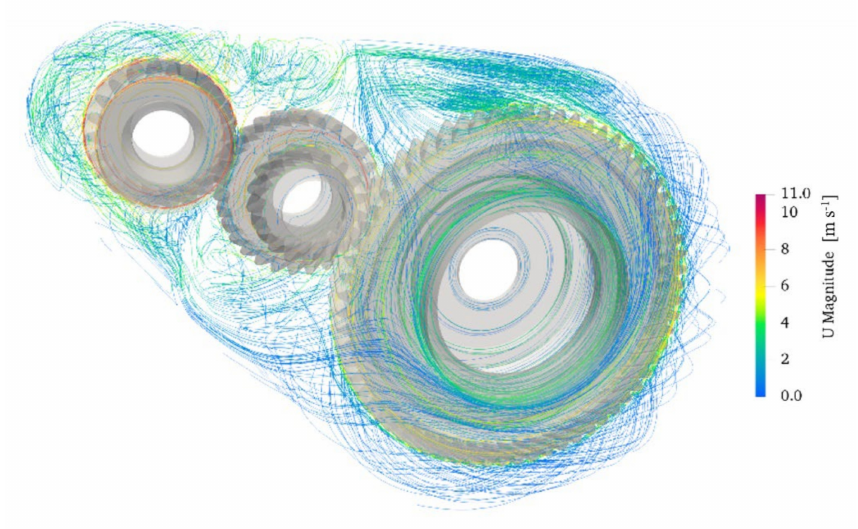
Figure 13. Velocity streamlines (U) and flow path inside the